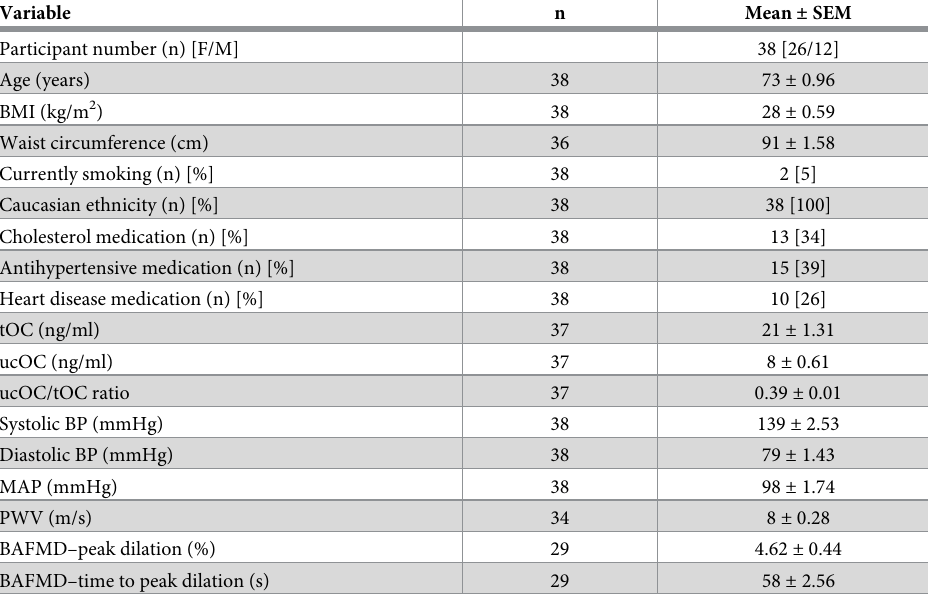
Table 1. Baseline